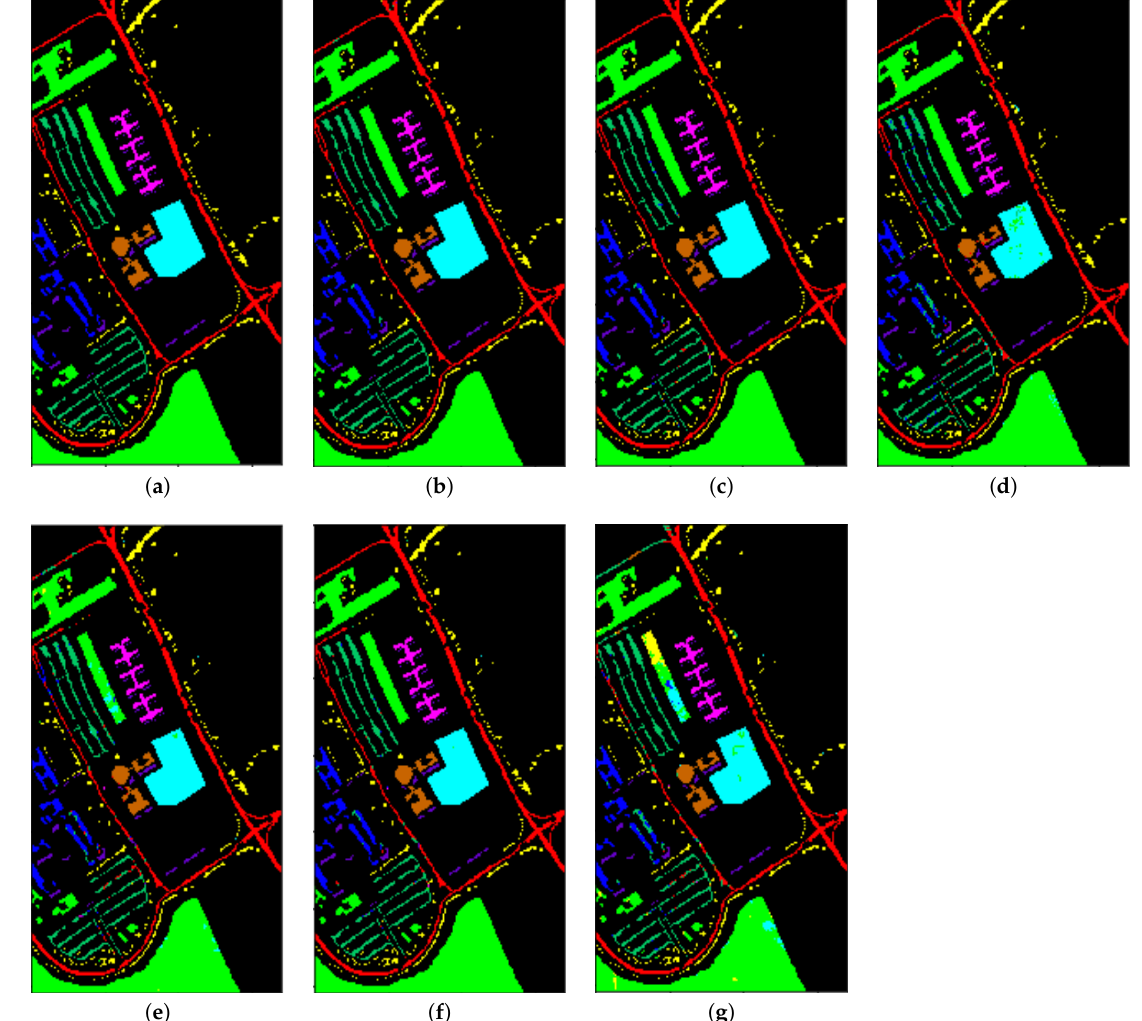
Figure 5. Classification maps of Pavia University dataset for the proposed dual-branch spatial- spectral attention-based classification framework and methodologies used for comparison using 5% training data. ( a ) Ground Truth; ( b ) SPAT-SPEC-HYP-ATTN (99.52%); ( c ) SPAT-HYP-ATTN (98.33%); ( d ) SPEC-HYP-ATTN (96.77%); ( e ) GAB-RP-S-3DCNN (97.13%); ( f ) SSAN (99.25%); ( g ) SVM-CK